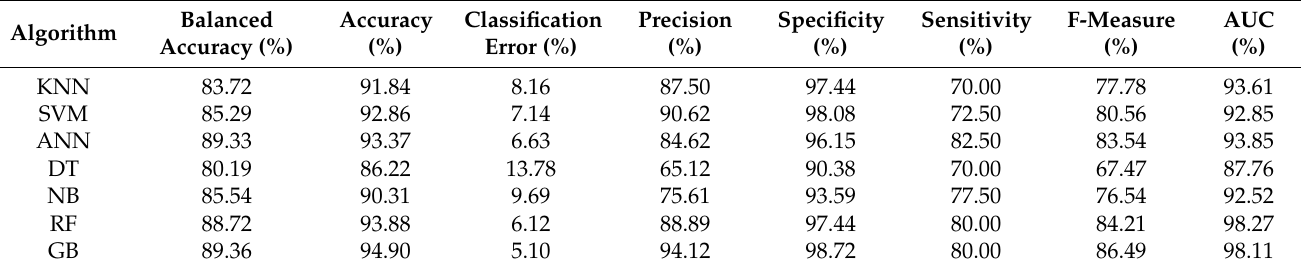
Table 7. Accuracy measures for model evaluation (performance